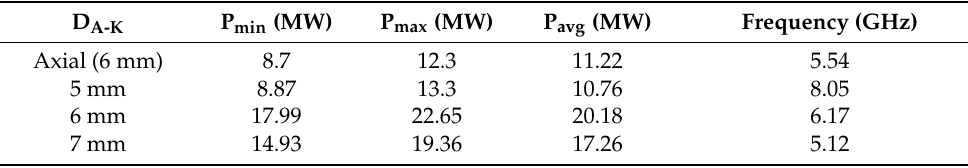
Figure 10. Typical frequency spectrum of the vircator (D A-K = 6 mm): ( a ) axial vircator and ( b ) coaxial vircator. Table 4. Experimental results on the